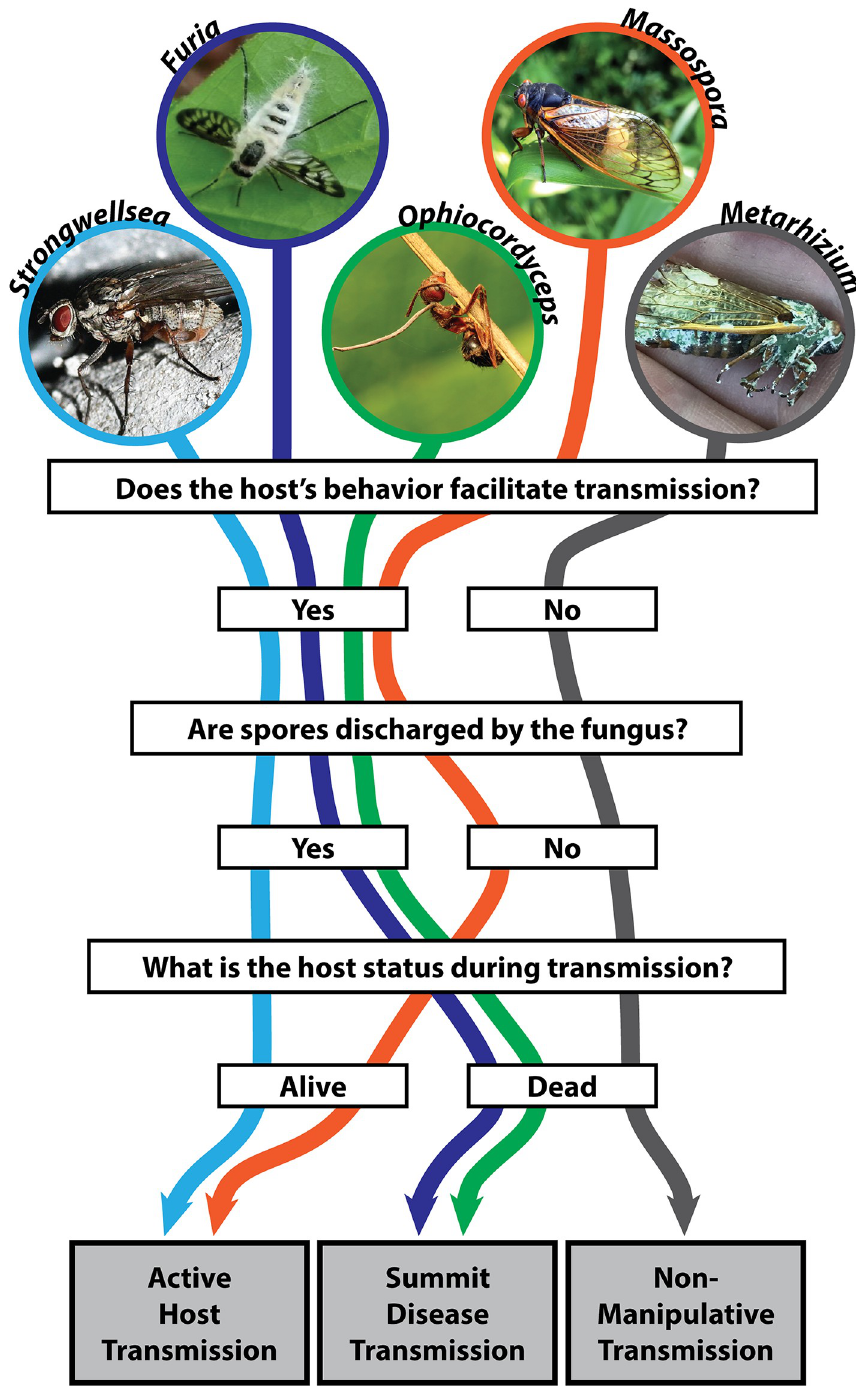
Fig 1. Flowchart of representative entomopathogenic fungi categorized by propensity to manipulate host behavior. This chart illustrates the host behavior, mode of sporulation, and host vitality that delineate which pathogens employ AHT, summit disease, or no behavioral manipulation during infection. The following fungus–host combinations are as follows: Strongwellsea aff. castrans – Hylemya vagans ; Furia ithacensis – Rhagionidae ; Ophiocordyceps spp.; Massospora cicadina – Magicicada septendecim ; and Metarhizium anisopliae – Magicicada septendecim . Photo credits to Matt Kasson, except for Strongwellsea (credit: Ju¨rgen Peters), Ophiocordyceps (credit: Katja Schulz), and Metarhizium (credit: John Boback). AHT, active host transmission.